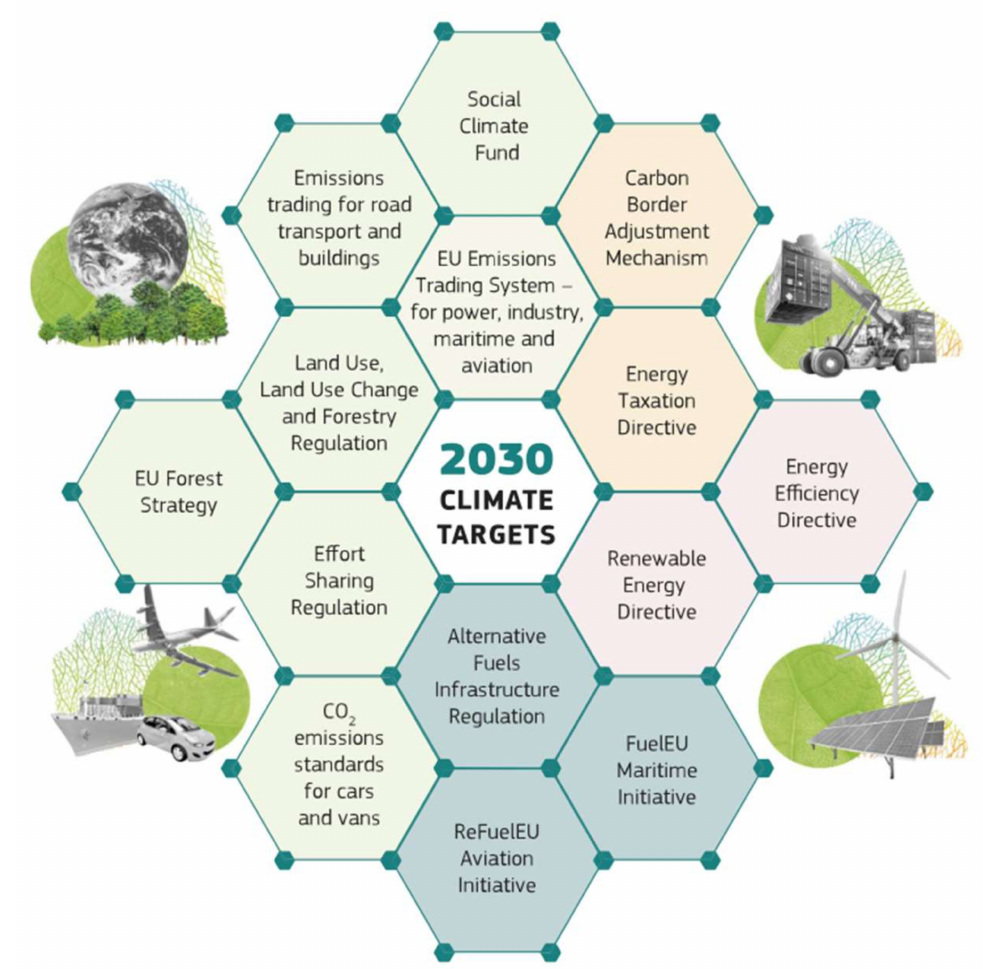
Figure 1. The legislative proposals made by the Commission will provide the necessary tools for the deep and just transformation of the EU’s economy envisaged by the European Green Deal. Source: https://op.europa.eu/webpub/com/general-report-2021/en/ (accessed on 10 December